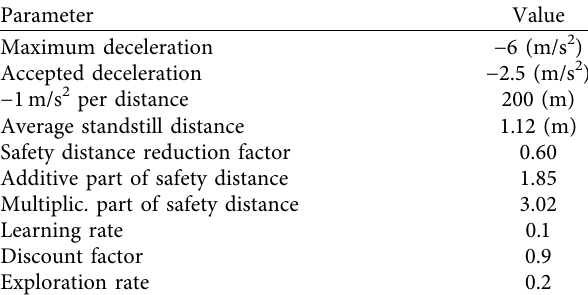
Table 1: Parameters and